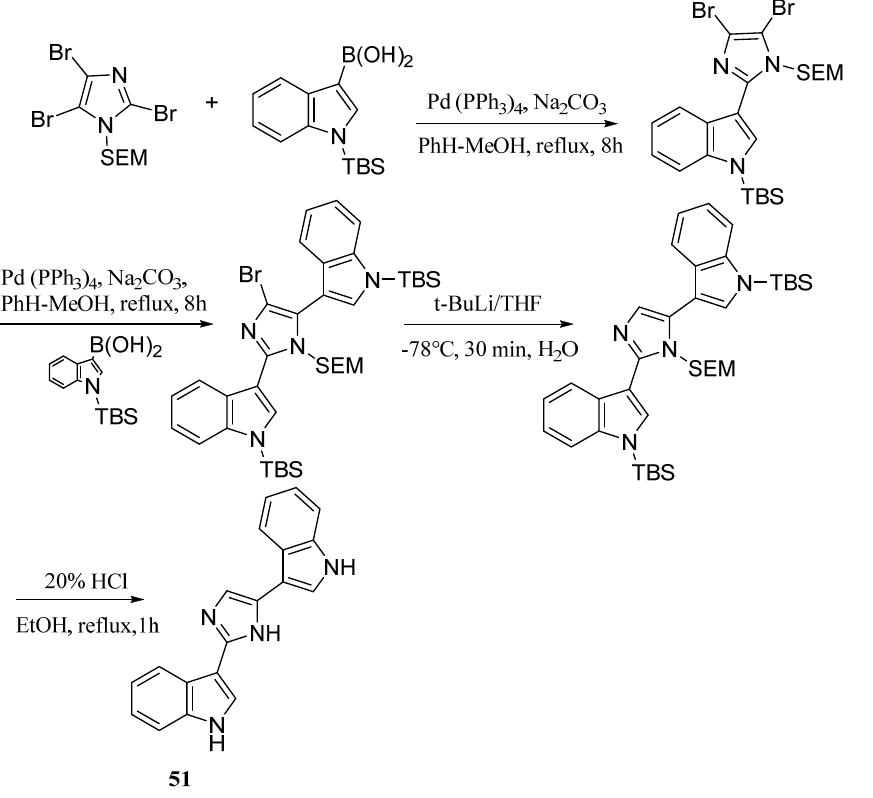
Scheme 8. The synthesis of nortopsentin D ( 51